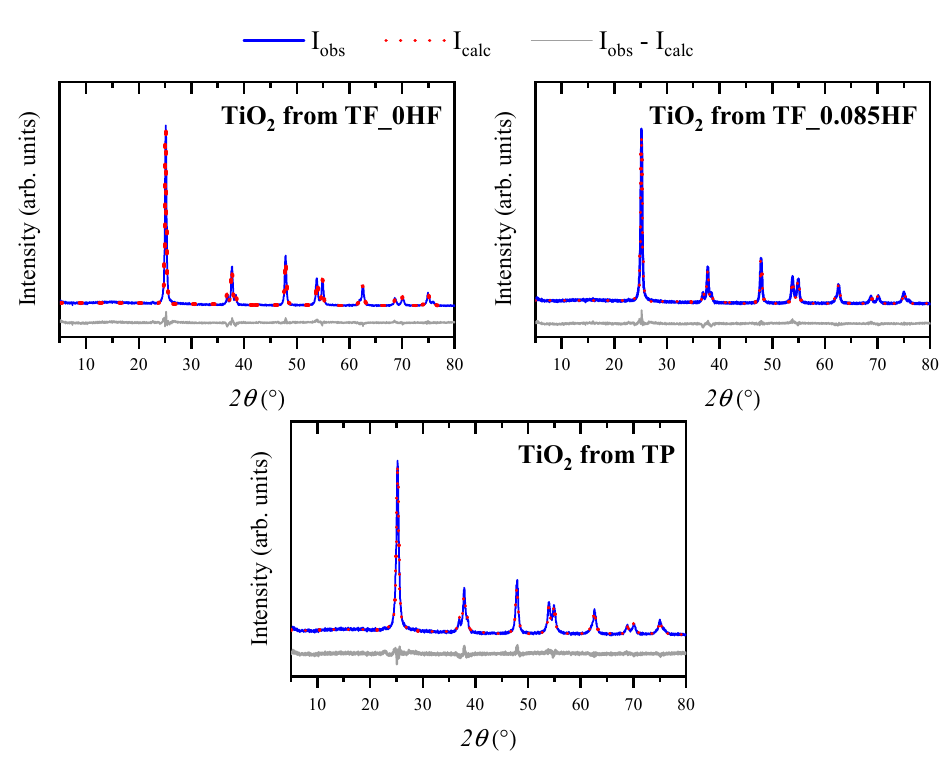
Figure 5. XRD patterns of F-modified TiO 2 . Table 3. Lattice and microstructural parameters of F-TiO 2 obtained by XRD, BET and EDS analysis.